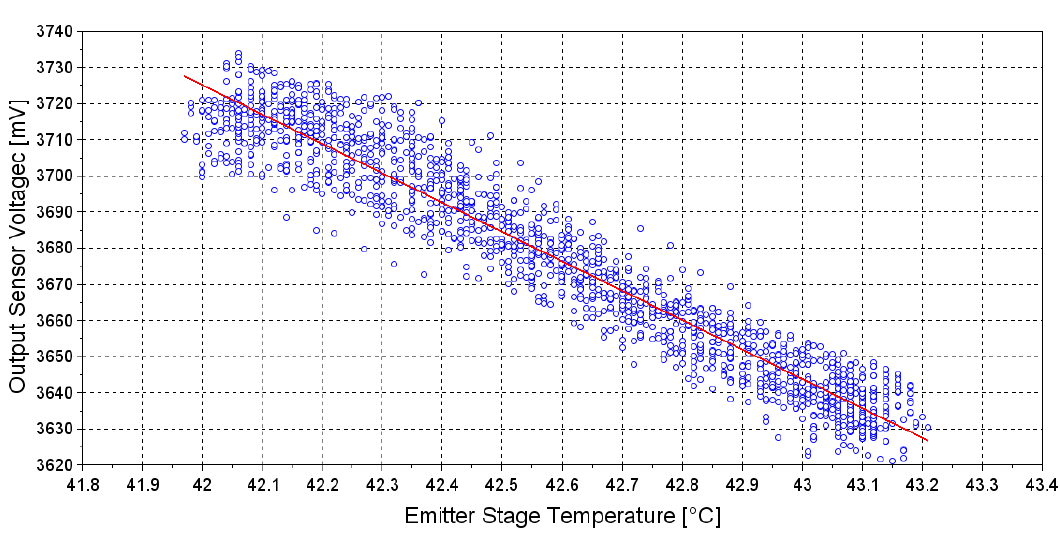
Figure 11. Experimental evaluation of correlation between emitted output power and emitter stage temperature. Blue dots represent the sampled value of the output sensor voltage at several temperatures of the emitter stage. Red line represents the linear regression of the